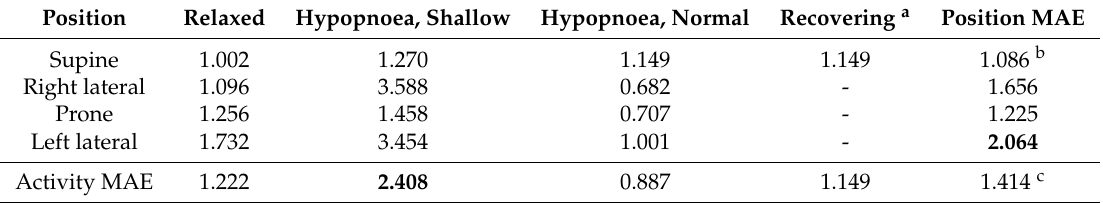
Table 7. Mean absolute error for respiration rates with respect to activity and lying